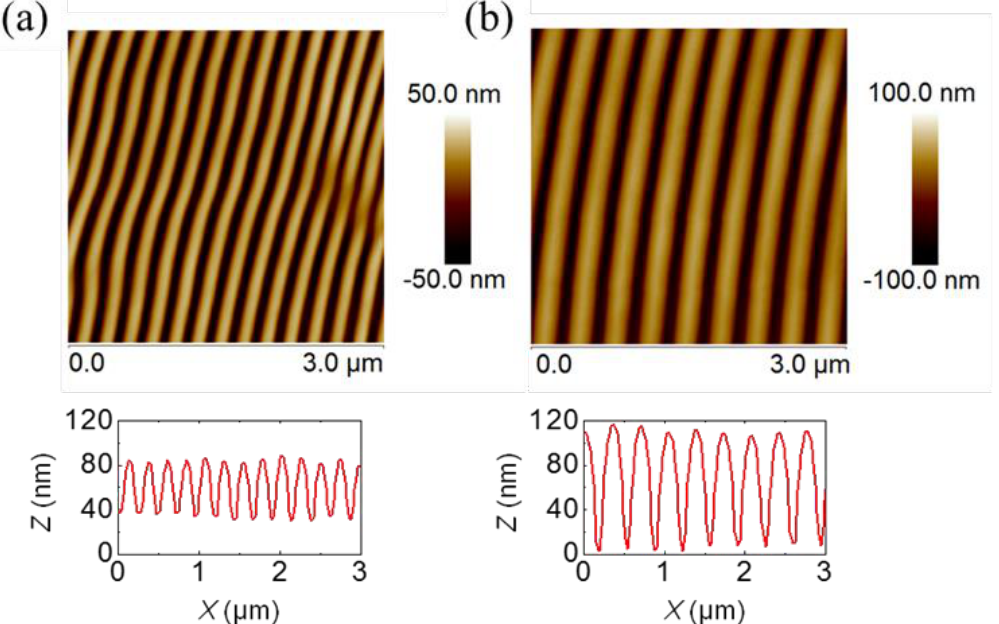
Figure 3. Topography AFM images of LIPSS fabricated with 3600 laser pulses on P3HT:PC 71 BM (1:1) at ambient conditions: ( a )  laser = 266 nm with a fluence of 13.5 mJ/cm 2 and ( b )  laser = 532 nm with a fluence of 26 mJ/cm 2 . The height profile along a 3 μm line perpendicular to the ripples is shown below both images. Periods of 225 ± 9 nm and depths of 61 ± 8 nm ( λ laser = 266 nm) and of 350 ± 8 nm and both images. Periods of 225 ± 9 nm and depths of 61 ± 8 nm (  laser = 266 nm) and of 350 ± 8 nm and depths of 111 ± 9 nm. ( λ laser = 532 nm) are depths of 111 ± 9 nm. (  laser = 532 nm) are obtained.